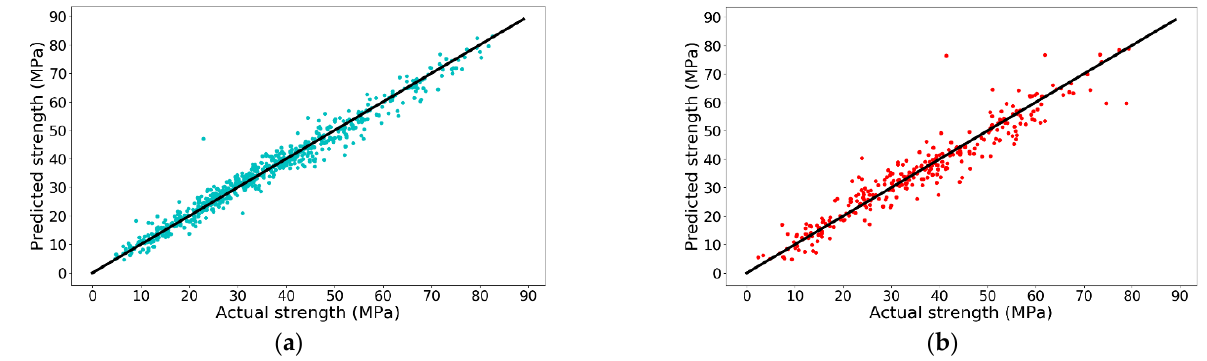
and the accuracy is shown in Figure 9.